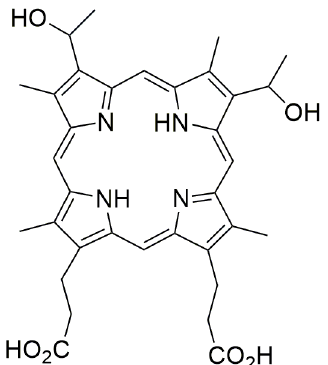
Figure 3 - Hematoporphyrin